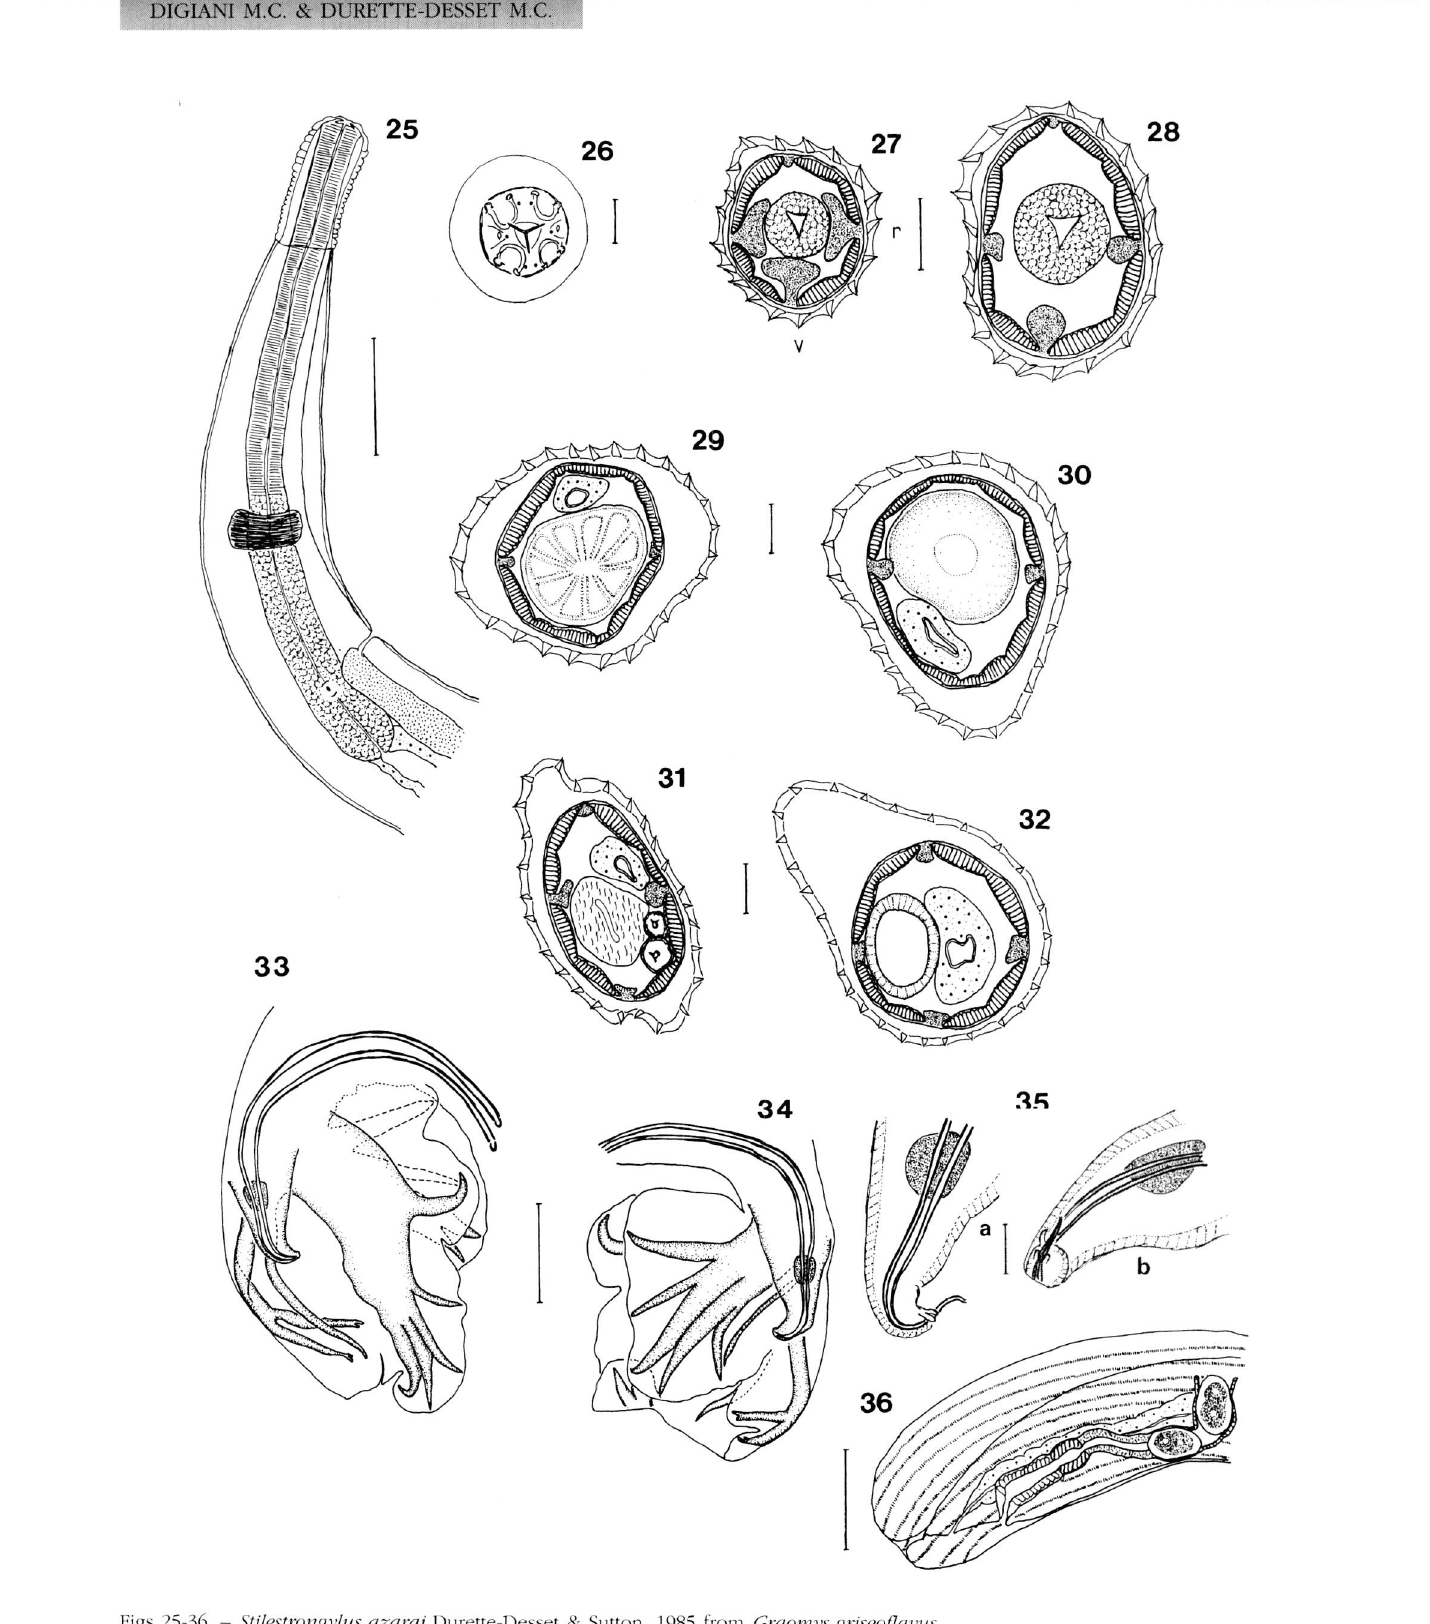
Figs 25-36. - Stilestrongylus azami Durette-Desset & Sutton, 1985 from Graomys griseoflavus. 25, male, anterior extremity, right lateral view. 26, female, head, apical view. 27-32. transverse sections of body; 27-28, at oesophago-intes- tinal junction, 27, male, 28, female; 29-30. at mid-body, 29, male, 30, female; 31-32, at posterior end, 31, male, 350 µm anterior to caudal bursa, 32, female, at 250 µm from posterior end. 33-34, male, caudal bursa, 33, right lobe, dorsal view (left rays in dotted lines), 34, left lobe, dorsal view (right rays in dotted lines). 35a, male, genital cone, lateral view. 35b. male, genital cone, ventral view. 36, female, pos terior extremity, left lateral view. Abbreviations: r, right, v. ventral. Scale bars: 25, 50 µm; 26, 10 µm; 27-32, 35, 20 µm; 33-34, 36, 100